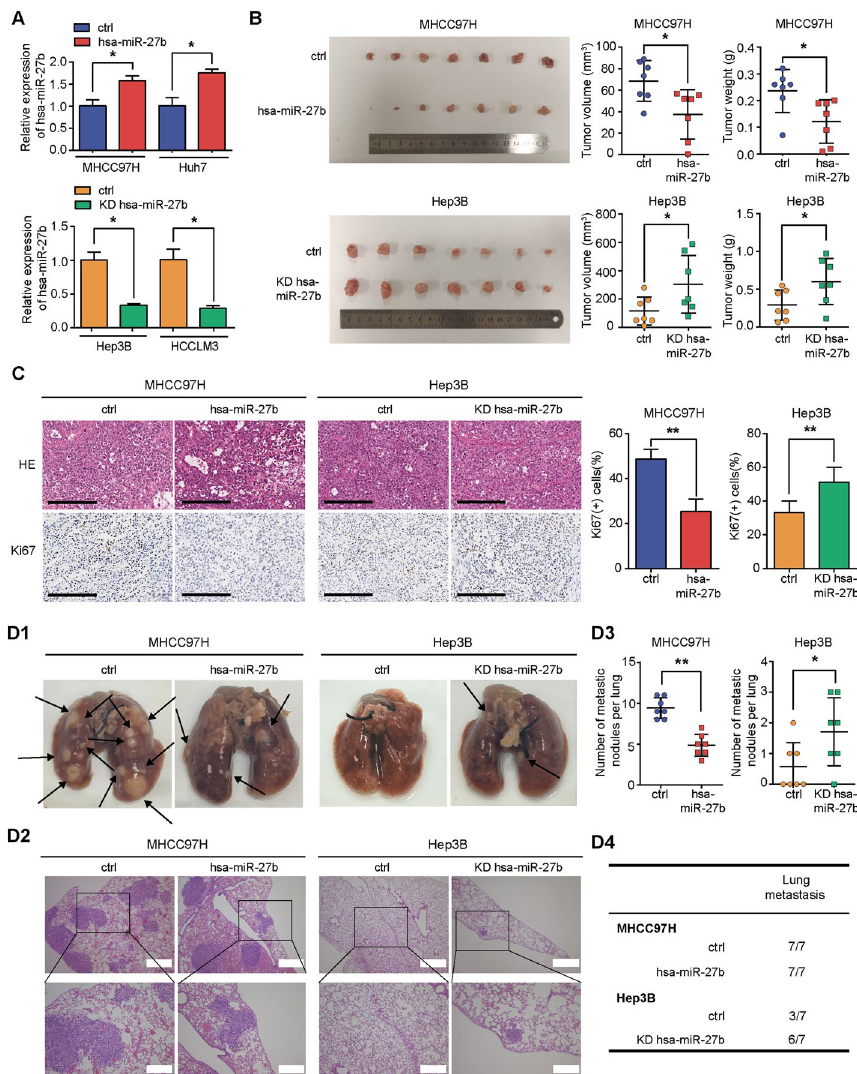
Fig. 3 Hsa-miR-27b inhibits the growth and lung metastasis of HCC cells in vivo. A qRT-PCR analysis of hsa-miR-27b stable overexpression or knockdown efficacy in the indicated cells. Data were normalized to U6 and are shown as fold change relative to the control cells ( n 3, Mann–Whitney test). B Macroscopic = images of subcutaneous tumours from mice ( n 7) bearing hsa-miR-27b -overexpressing MHCC97H cells = or hsa-miR-27b -knockdown Hep3B cells (left); quantification of the volumes and weights of subcutaneous tumours in the indicated groups (right); unpaired t -test. C Representative haematoxylin and eosin (H&E) staining and IHC of Ki67 in subcutaneous xenografts. Quantification of staining scores was calculated ( n 7, = unpaired t -test); Scale bar, 200 μm. D Lung metastasis experiments were performed in nude mice with the indicated cells. D1 and D2 Representative macroscopic and H&E staining images of lung metastases. D3 Quantification of visible tumour nodules. MHCC97H: control group ( n 7); hsa-miR-27b group ( n 7); = = unpaired t -test. Hep3B: control group ( n 7); KD hsa-miR-27b group ( n 7); Mann–Whitney test. D4 Lung = = metastatic incidence in different groups; * p < 0.05. ** p < 0.01. Data are shown as mean SD. ctrl, control; ±